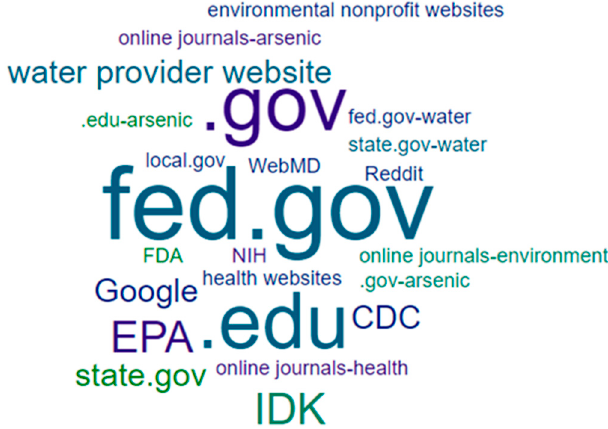
Figure 4. Student-identified sources of reliable information.